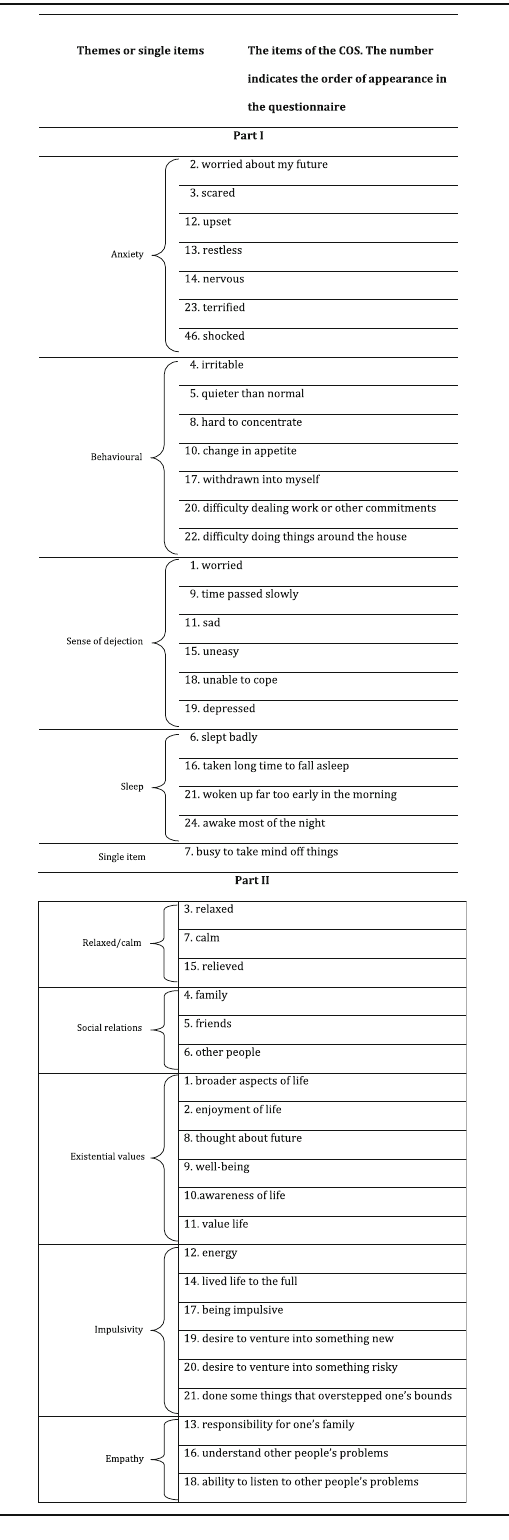
Table 1 Content of the core-questionnaire COS (Consequence of